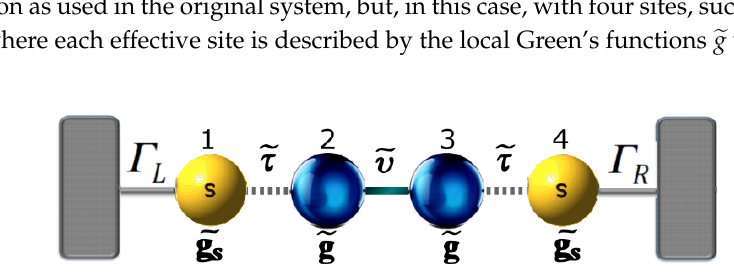
Figure A2. Molecular system with a renormalized thiophene